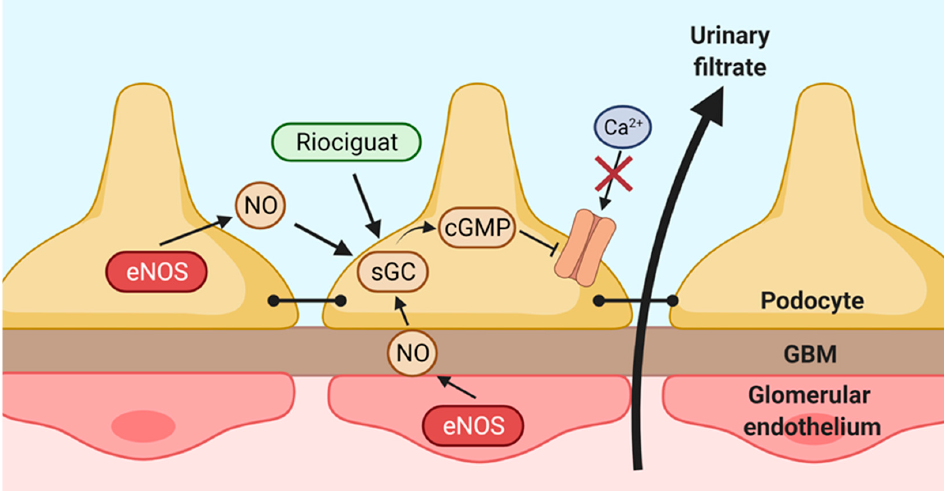
Figure 9. Schematic overview of the hypothetical paracrine (e)NOS-NO-sGC axis in the glomerulus. Nitric oxide (NO) is produced by endothelial nitric oxide synthase (eNOS) in glomerular endothelial cells (GEnC) and diffuses across the glomerular basement membrane (GBM) to the podocytes. In the podocyte, NO stimulates its receptor soluble guanylate cyclase (sGC) leading to increased cyclic guanosine monophosphate (cGMP) synthesis. The increased cGMP production inhibits the expression and activity of the Ca 2+ -channel transient receptor potential channel 6 (TRPC6), thereby inhibiting deleterious TRPC6 signaling and preventing downstream podocyte injury. NO might also be produced by podocytes themselves, thereby constituting a protective autocrine loop. In addition to NO, the sGC stimulator Riociguat, currently market approved for treatment of pulmonary arterial hypertension (PAH), might activate sGC to prevent podocyte